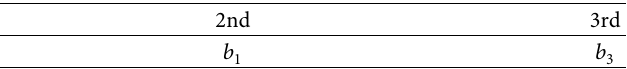
Figure 1: Score, Accuracy & Ranking Comparison for F Table 4: Rankings of bridge designs under ( C , ⊚ ) .